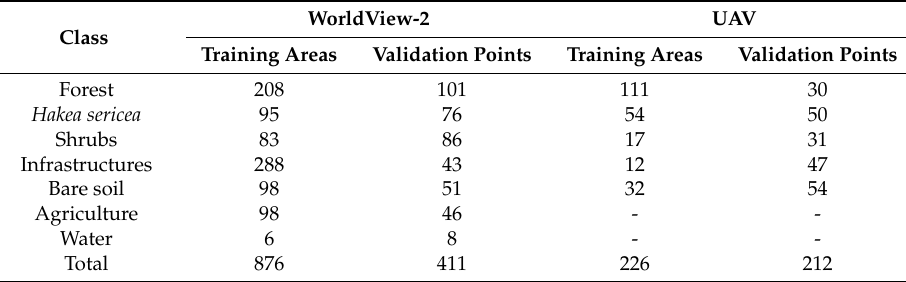
Table 1. Training areas and validation points for each land cover